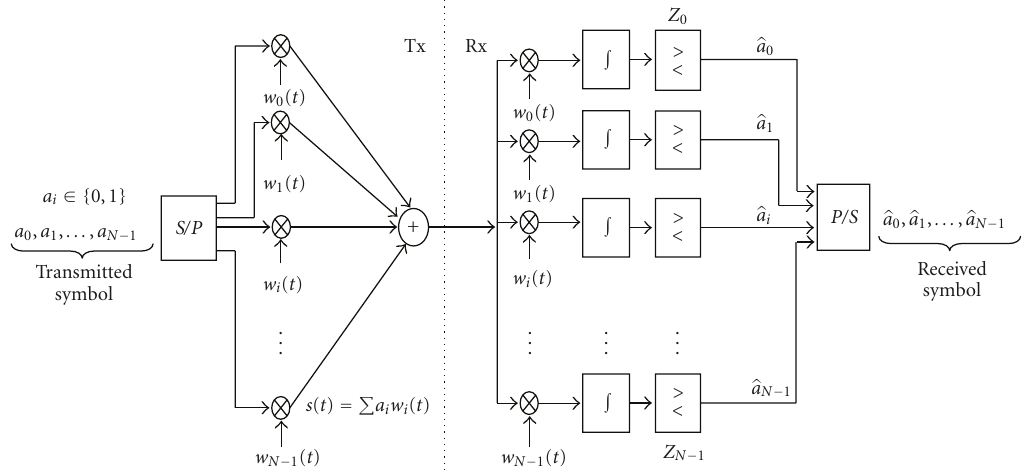
Figure 2: Correlation transceiver structure for N -bit OOK-PSM modulation scheme in AWGN